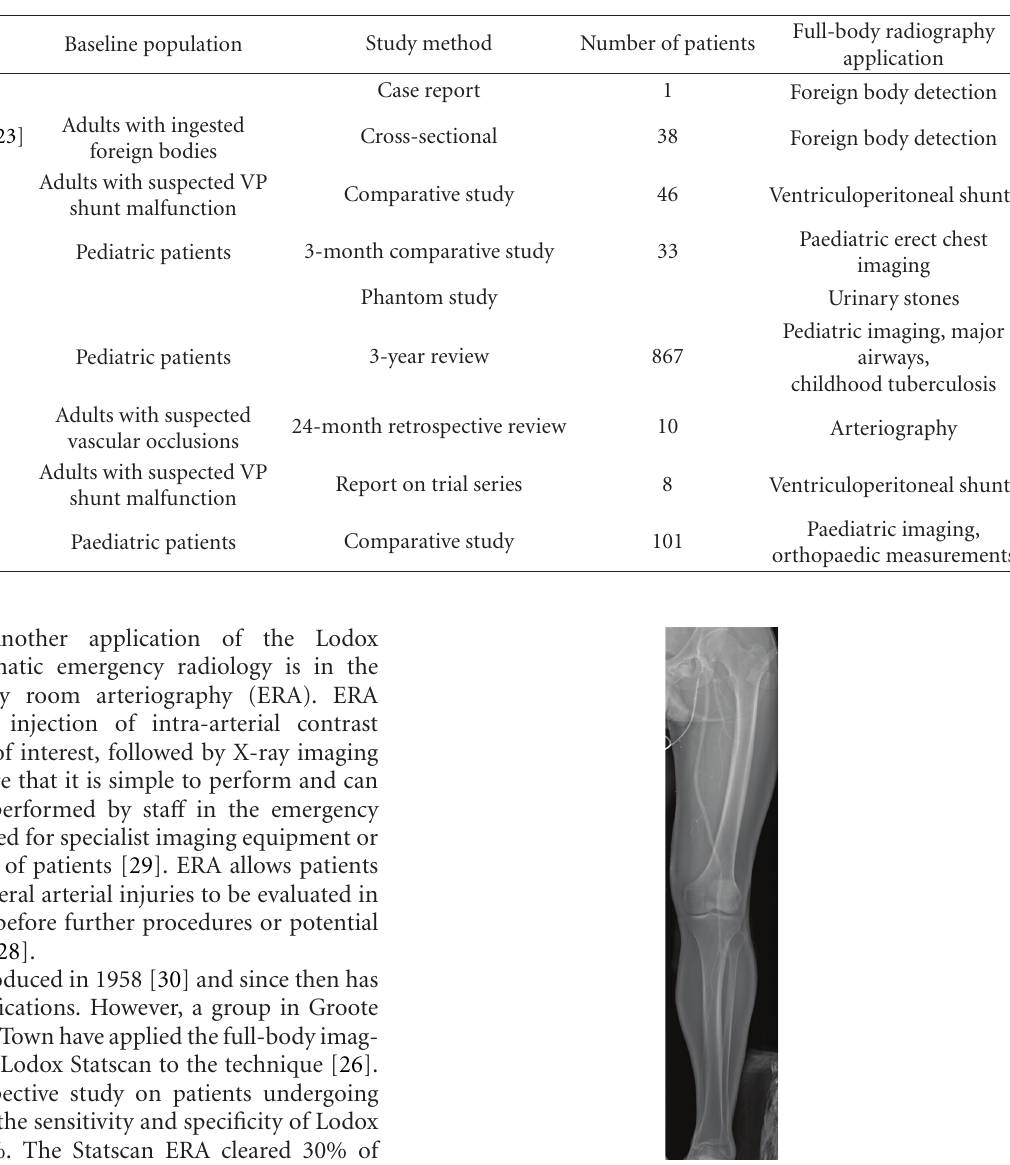
Figure 2: Example of Emergency Room Arteriography using the Lodox Statscan. Notice the occlusions at the proximal region of interest, and distal to